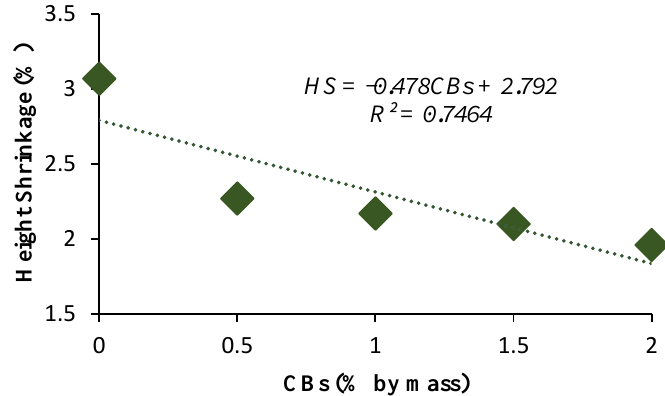
Figure 7. Height shrinkage versus CB percentage by mass.